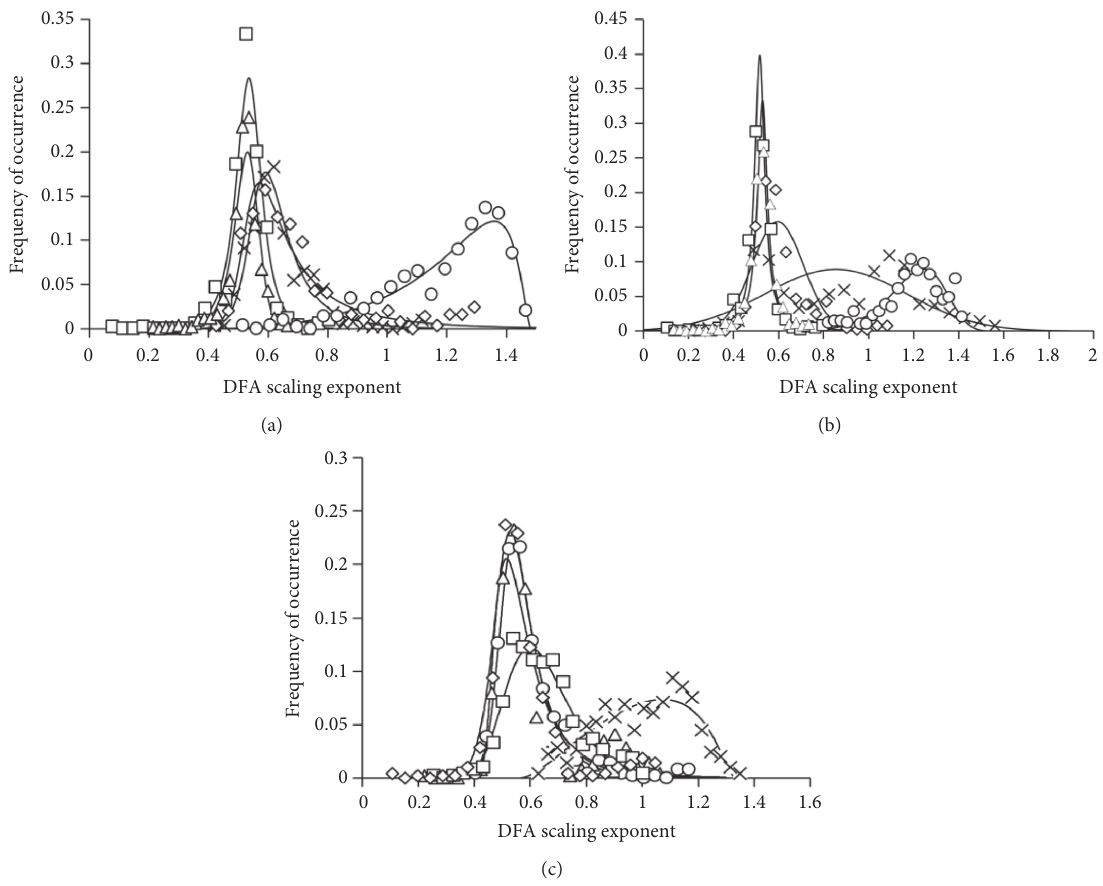
Figure 3: Frequency of occurrence of DFA scaling exponents of RTT time series calculated for first (a), second (b), and third (c) days, day-time measurements. Scaling exponents have been calculated for consecutive 1000 data windows shifted by 100 data steps. Crosses: GTU, squares: Harvard, diamonds: UCLA, triangles: USC, and circles: